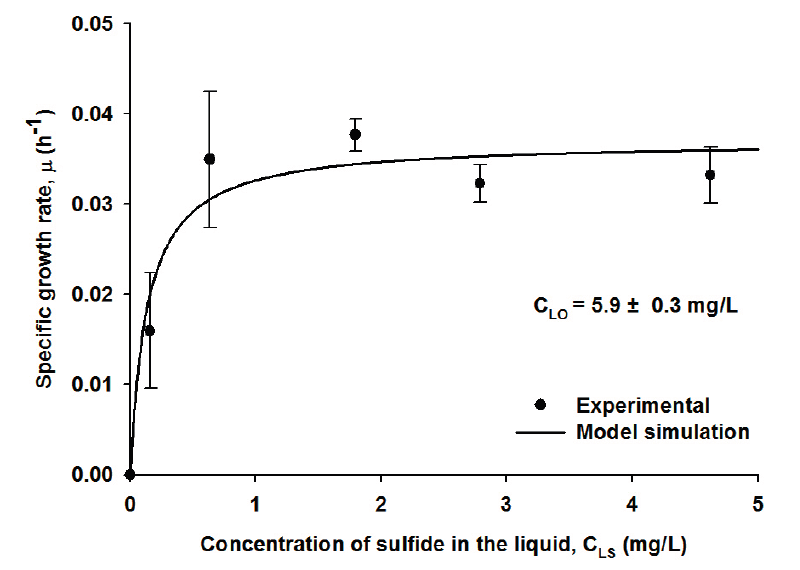
Figure 1. The specific growth rates of the SOB strain at different H 2 S concentrations in the liquid medium. The symbols show averaged experimental data with standard deviations, and the line illustrates model